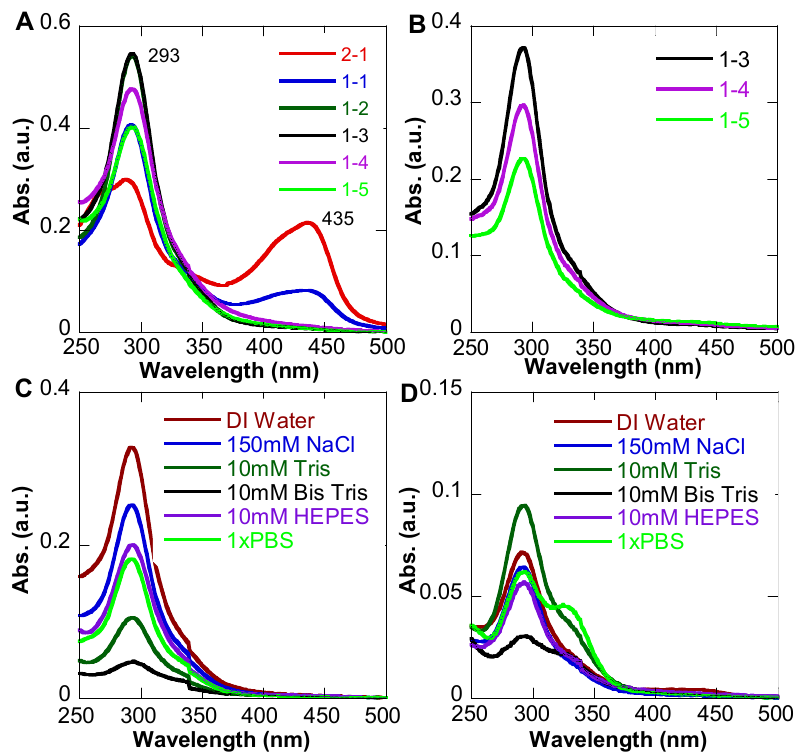
Figure 4. UV-Vis spectra of QFeNPs at various conditions after two weeks: ( A ) as-synthesized NPs at various ratios in 50/50 methanol/water; ( B ) NP powders with Q-Fe ratios of 1:3, 1:4, and 1:5 after freeze-drying; ( C ) QFeNPs with a Q-Fe ratio of 1:4 in different solutions; and ( D ) QFeNPs with a Q-Fe ratio of 2:1 in different solutions.